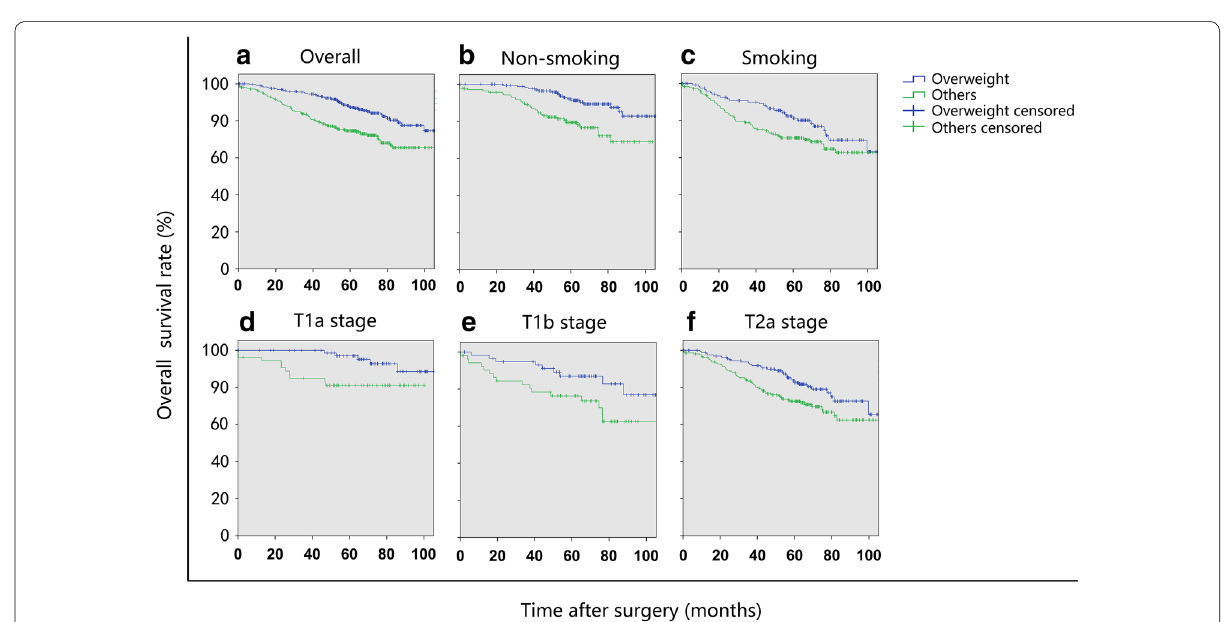
Fig. 3 Kaplan–Meier OS curves of stage I NSCLC patients in the overweight group and other groups in combination stratified by smoking status and T stage. a The OS was longer in the overweight group than in other groups in combination ( P was longer in the overweight group than in other groups in combination ( P between the overweight group and other groups in combination ( P weight group than in other groups in combination ( P the overweight group and other groups in combination ( P longer than that of other groups in combination ( P